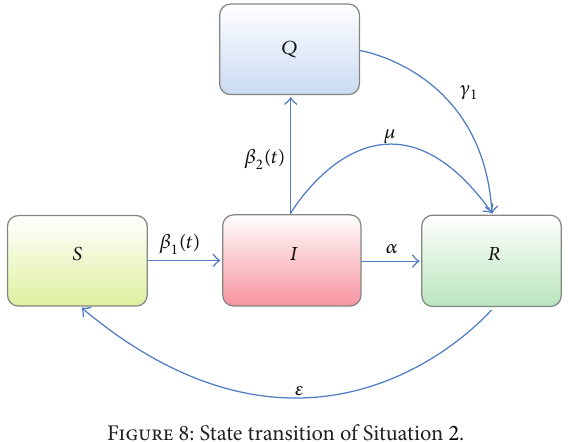
Figure 8: State transition of Situation